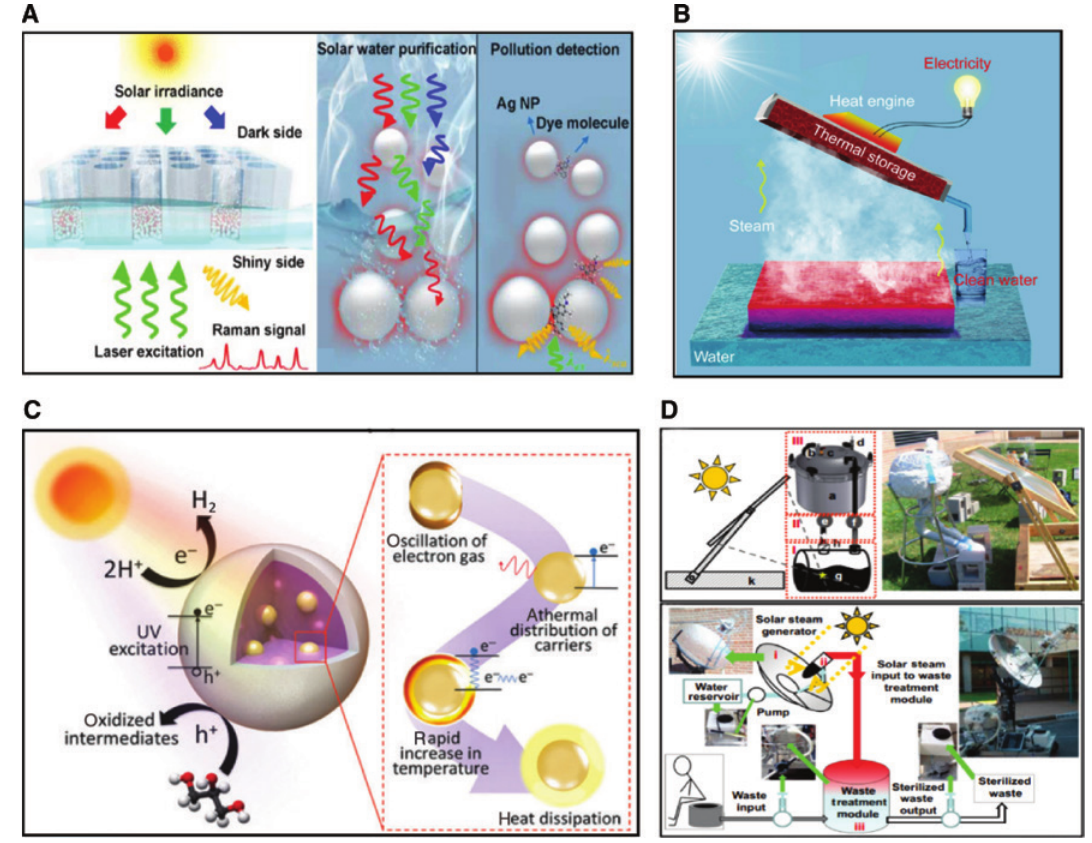
Figure 7: Dual-functional applications of plasmon-enhanced solar evaporation. (A) Asymmetric plasmonic structures for solar water purification and pollution detection [107]; (B) clean water collection accompanied by the electric energy generation [108]; (C) SiO /Ag core-TiO shell nanoparticles structures for both clean water generation and 2 2